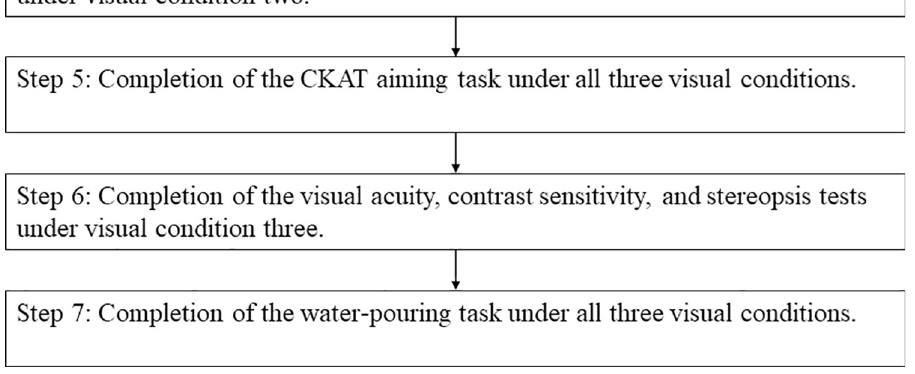
Fig 2. Experimental procedure flowchart. The order of visual condition completed (unilateral, bilateral and no impairment) was counter-balanced, so condition one refers to no impairment for some participants, unilateral impairment for others and so